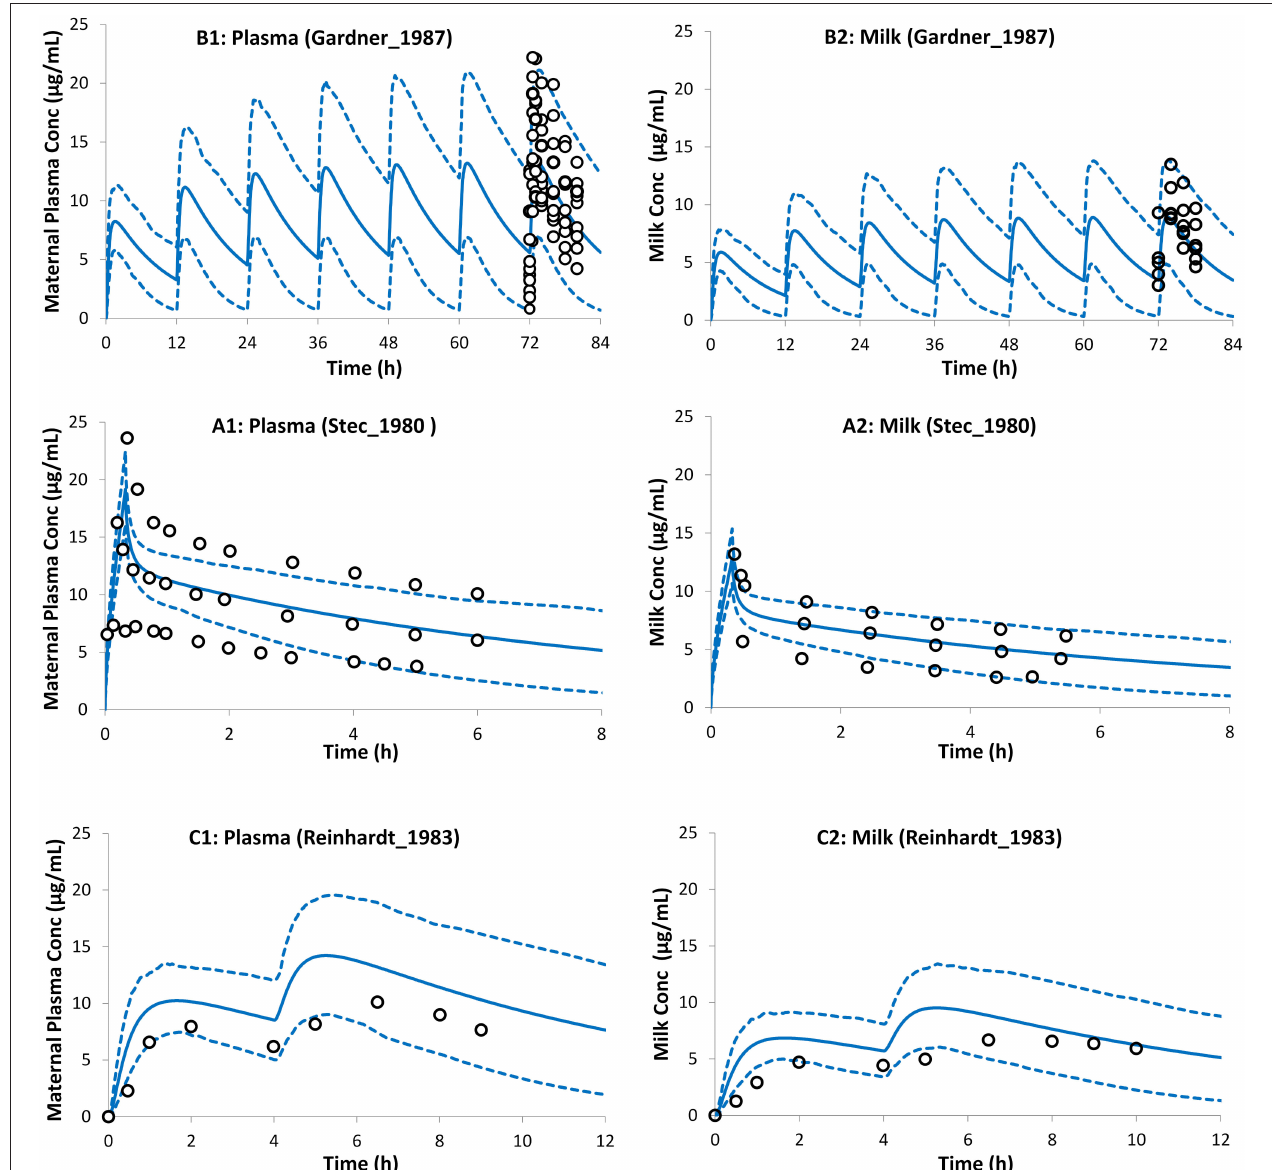
FIGURE 4 | Theophylline concentration profiles in maternal plasma (left) and the milk (right). Milk exposure was predicted using the average predicted M/P ratio from both lactation models (see Method section). Solid lines, predicted means; Dashed lines, 5th and 95th centiles; Circles, individual observations (open, maternal; filled, milk). (A1,A2) Trial design L1 (45), (B1,B2) Trial design L2 (51), and (C1,C2) Trial design L3 (52). See the Method section for trial